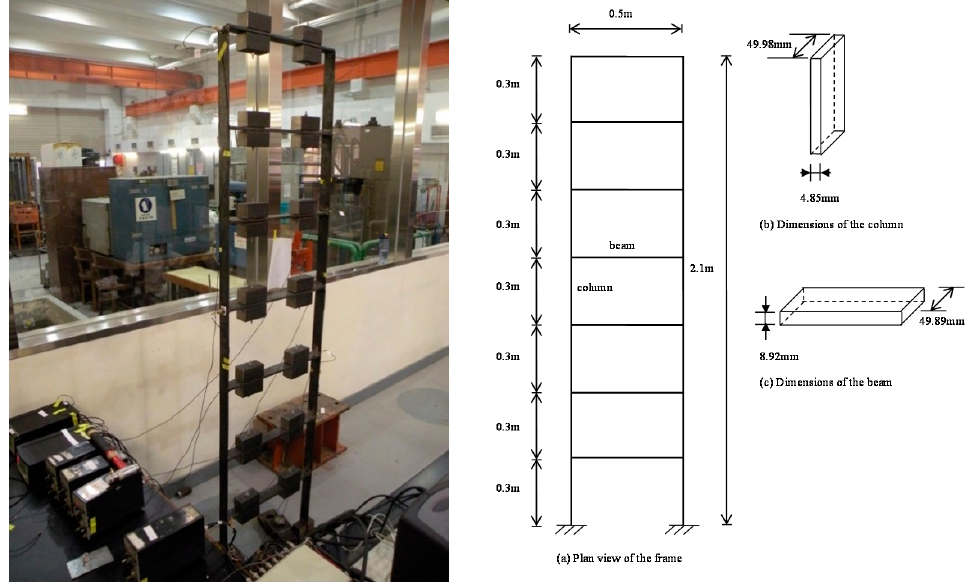
Figure 3. Laboratory steel frame model and the dimensions of the steel frame structure.